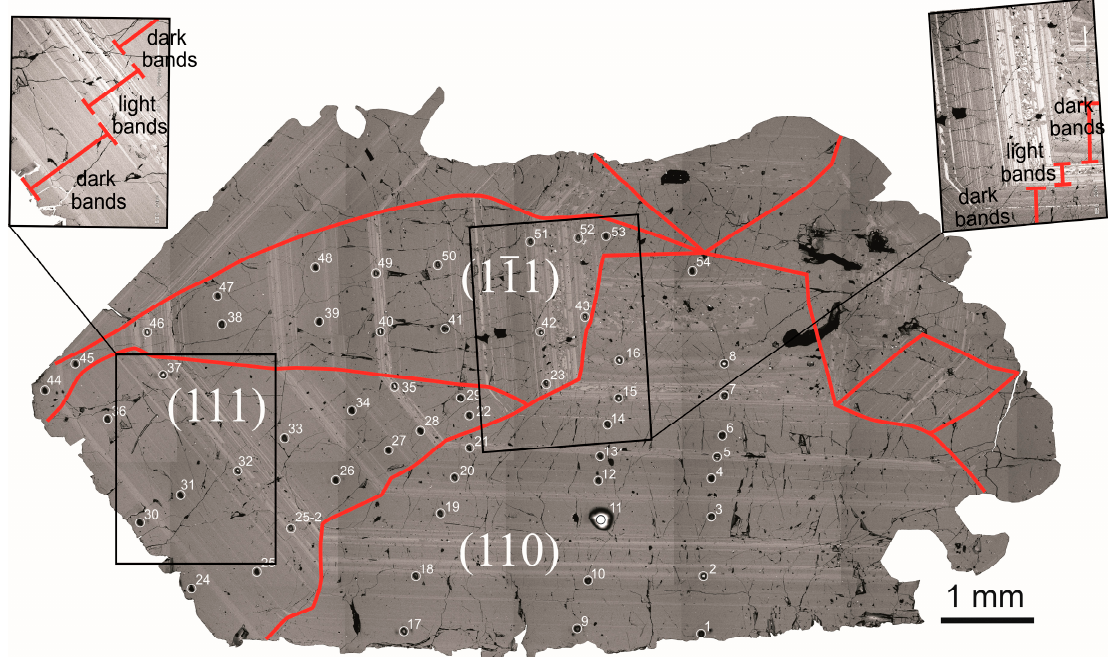
Figure 2. BSE image of zircon crystal from Ilmen Mountains feldspathic pegmatite. White circles encircle the craters of the ion microprobe, indicating the sequence number of analytical points. Red lines indicate the boundaries of growth sectors on the crystal.